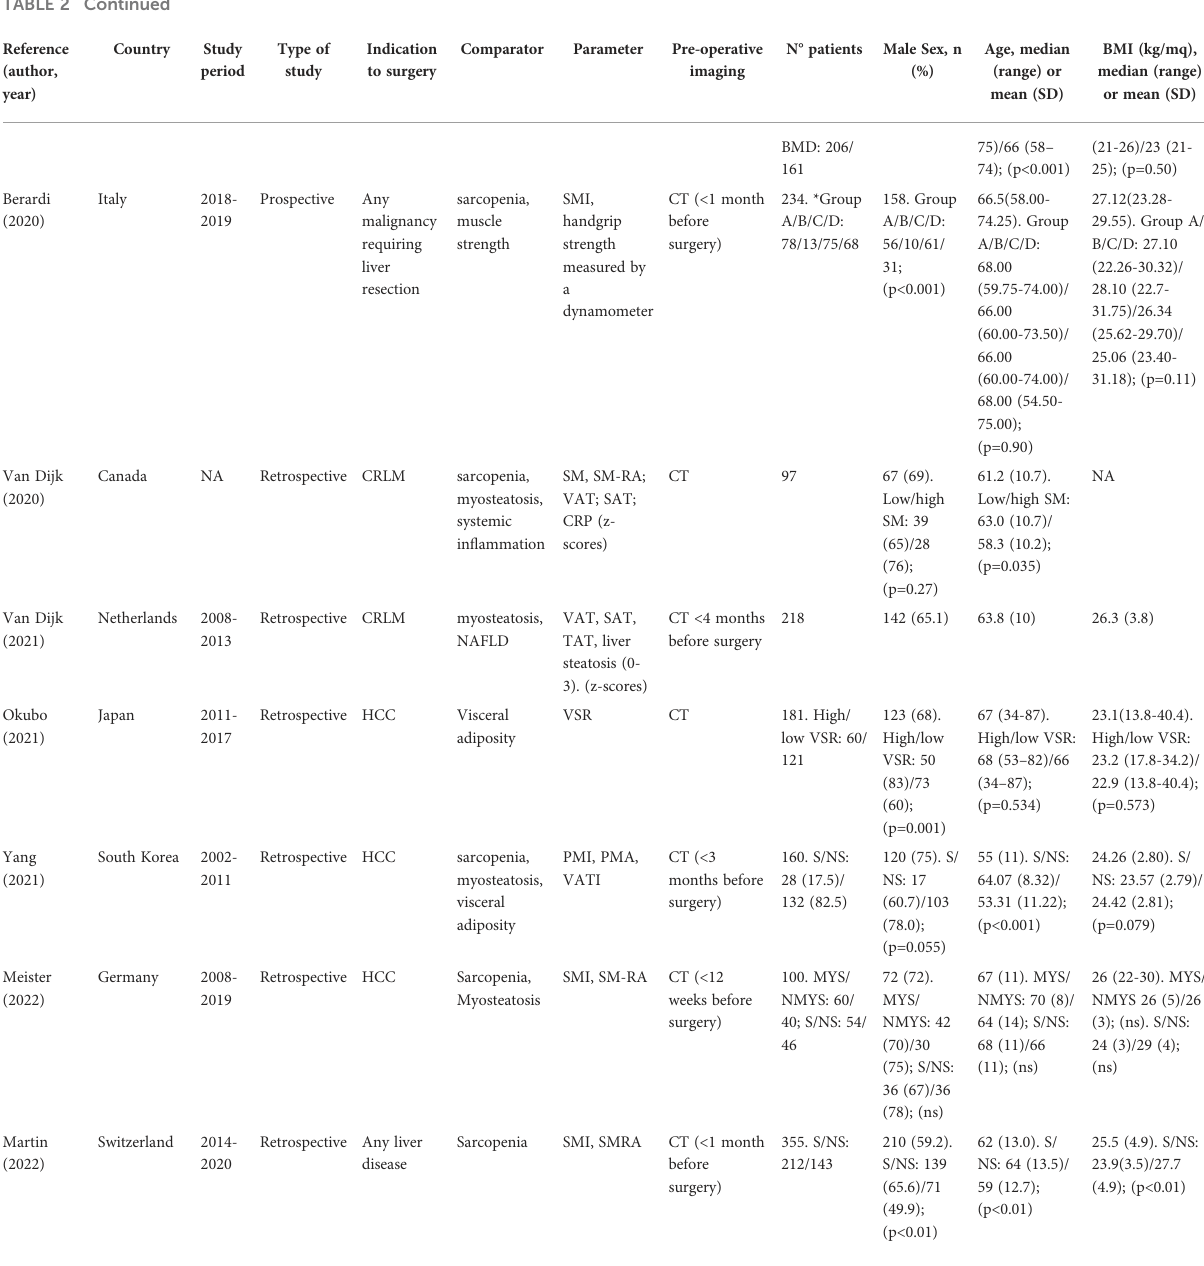
intra-abdominal infections (5.9%) bile leak (3.5%) and ascites (3.5%) but again without signi fi cant differences compared to patients presenting high visceral adiposity (20). None of the studies included reported signi fi cantly increased infectious complications rate in sarcopenic vs. non-sarcopenic HCC